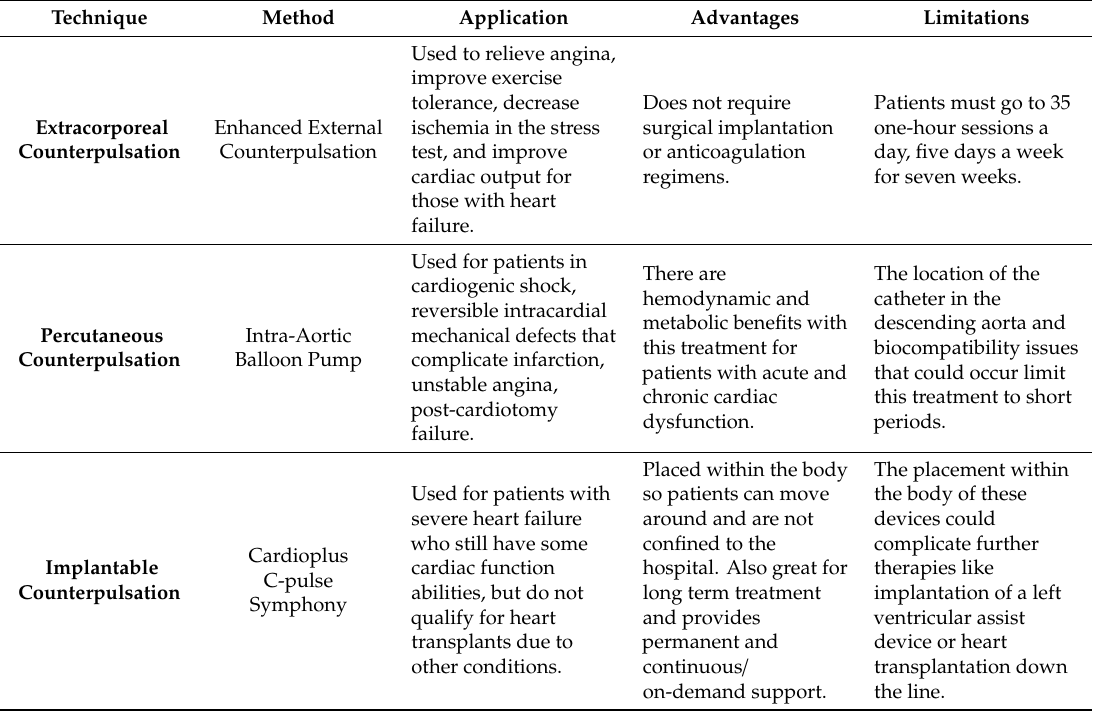
Table 1. Counterpulsation Techniques [33].